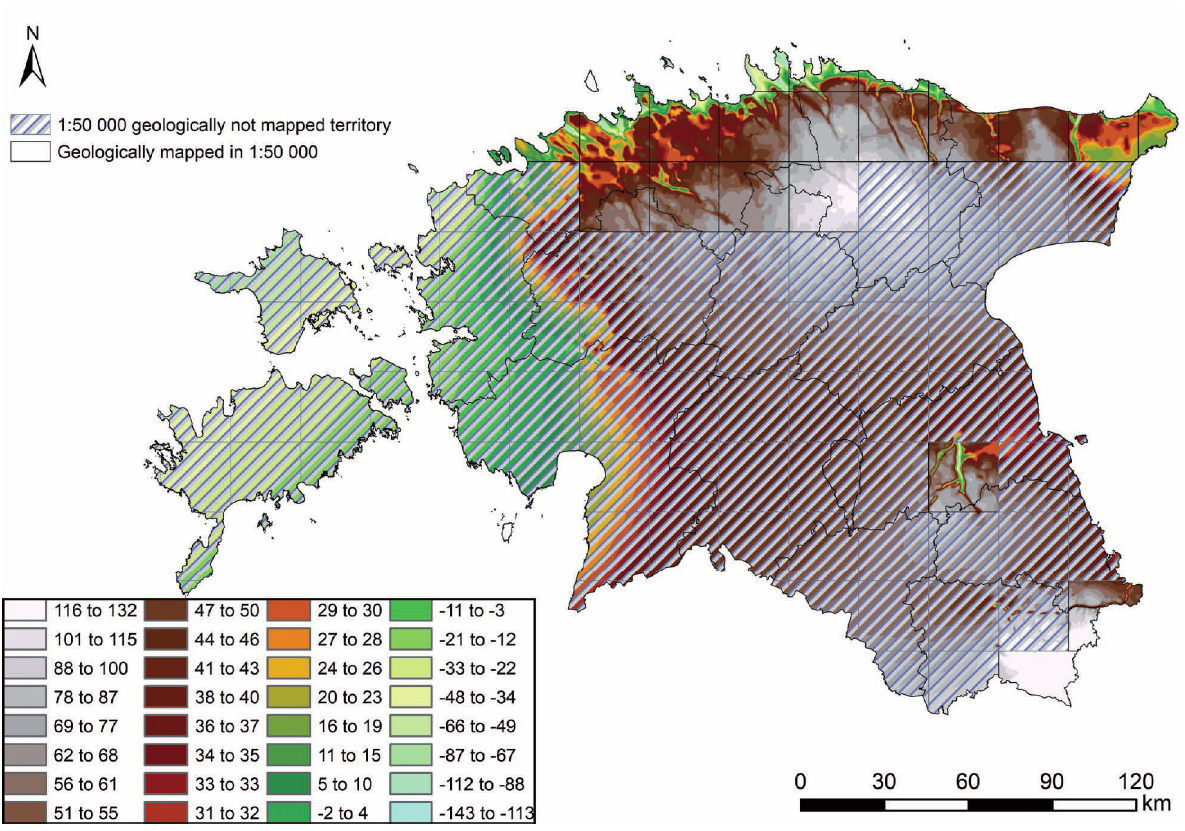
Fig. 2. The bedrock model of the geological map of Estonia (1:50 000) (EGS 2018) and the mapped area. Surface values are metres above sea